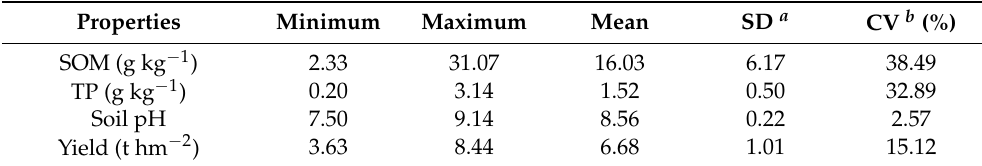
Table 1. Descriptive statistics of the sample data for wheat yield, soil organic matter (SOM), total phosphorus (TP), and soil pH ( n = 99).